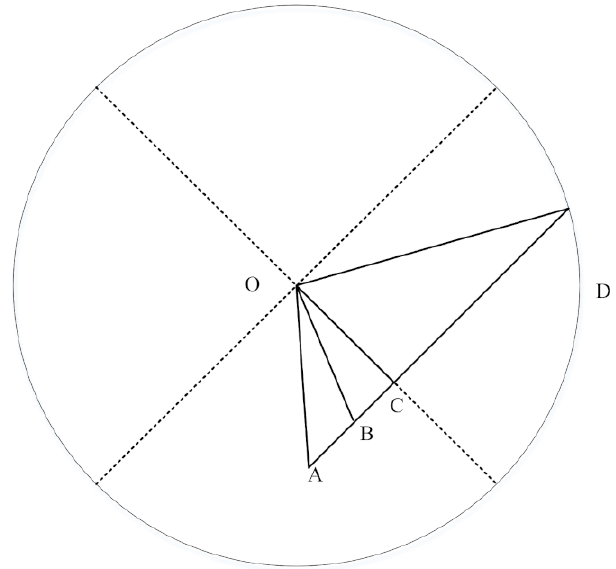
Figure 4. Task Offloading Process Movement Model. The connection boundary of the wireless network is a circular shape. Its center, O, is the transmitting and receiving antenna of the signal of the offload terminal device, which represents the terminal location of the current task offload of the network. The radius of the boundary circle (indicated by the dotted line) is the connection range of the infinite network, and the solid line indicates the moving path of the terminal equipment within the circle, where Point A represents the initial position of the offloading site when the task is unloaded, and Points B, C and D are the positions of the offloading site in the process of